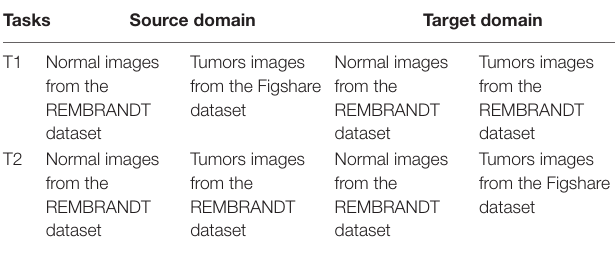
Tumors images from the Figshare dataset